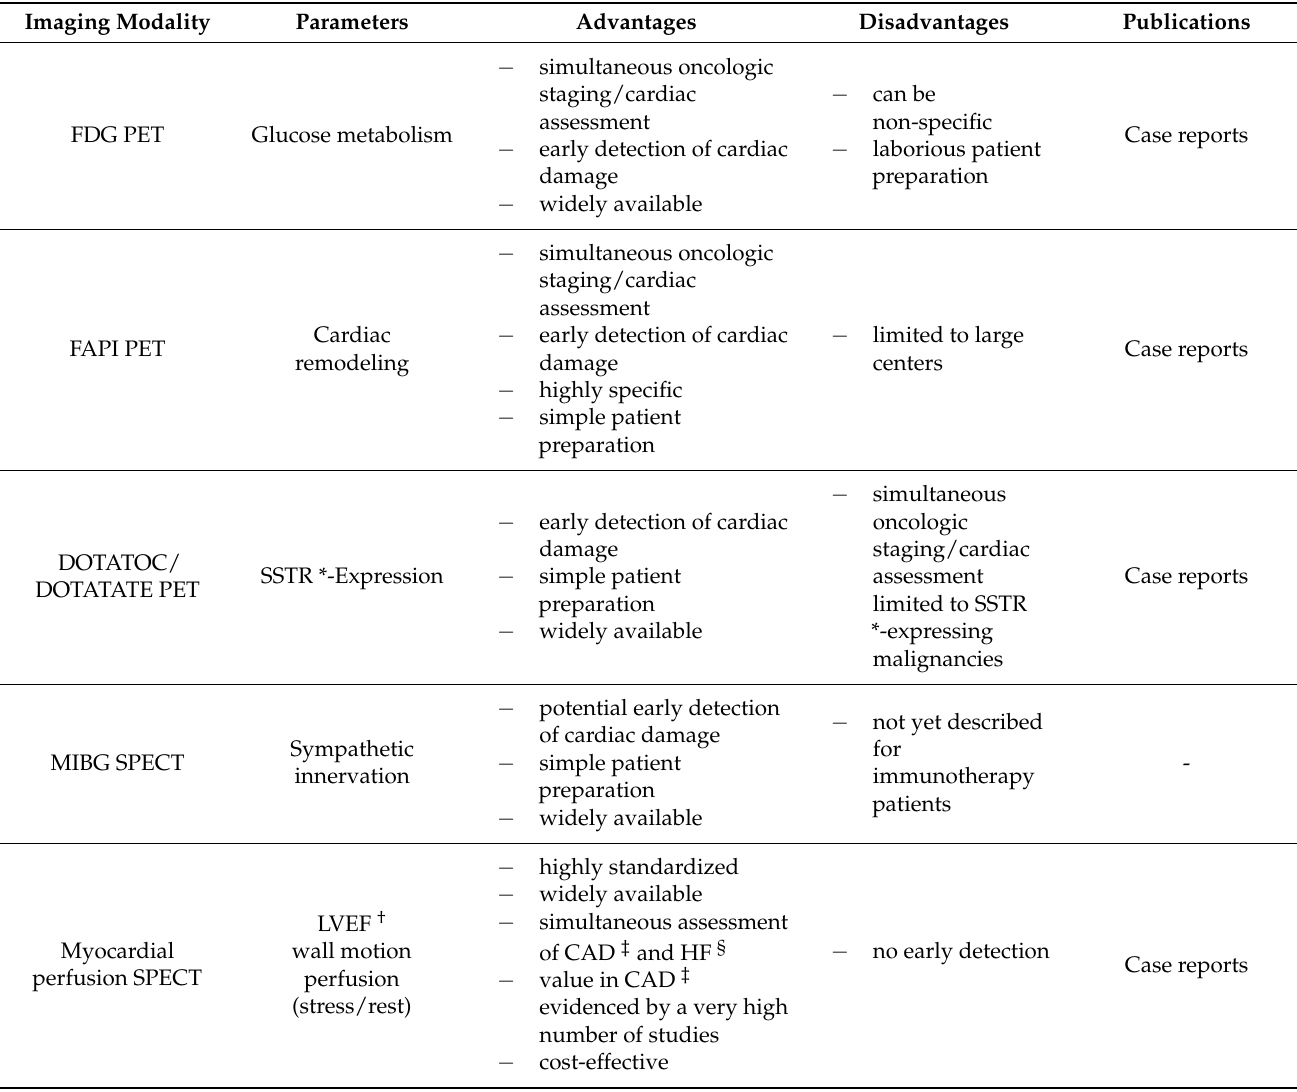
Table 1. Most promising nuclear cardiology examination methods for assessment of immunotherapy- related